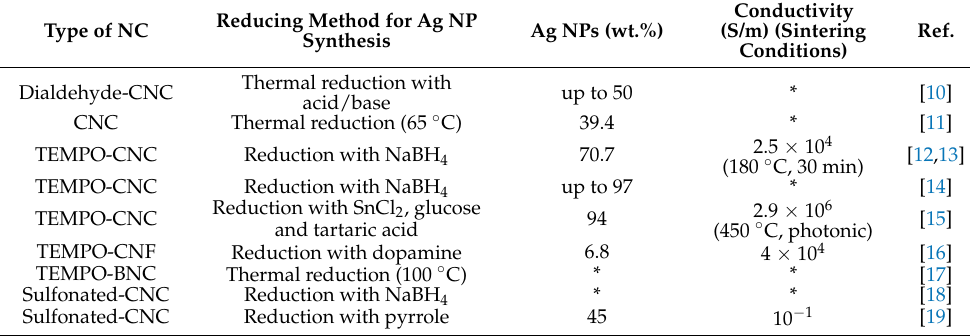
Table 1. Summary of the most relevant Ag NP/NC composites and inks found in the